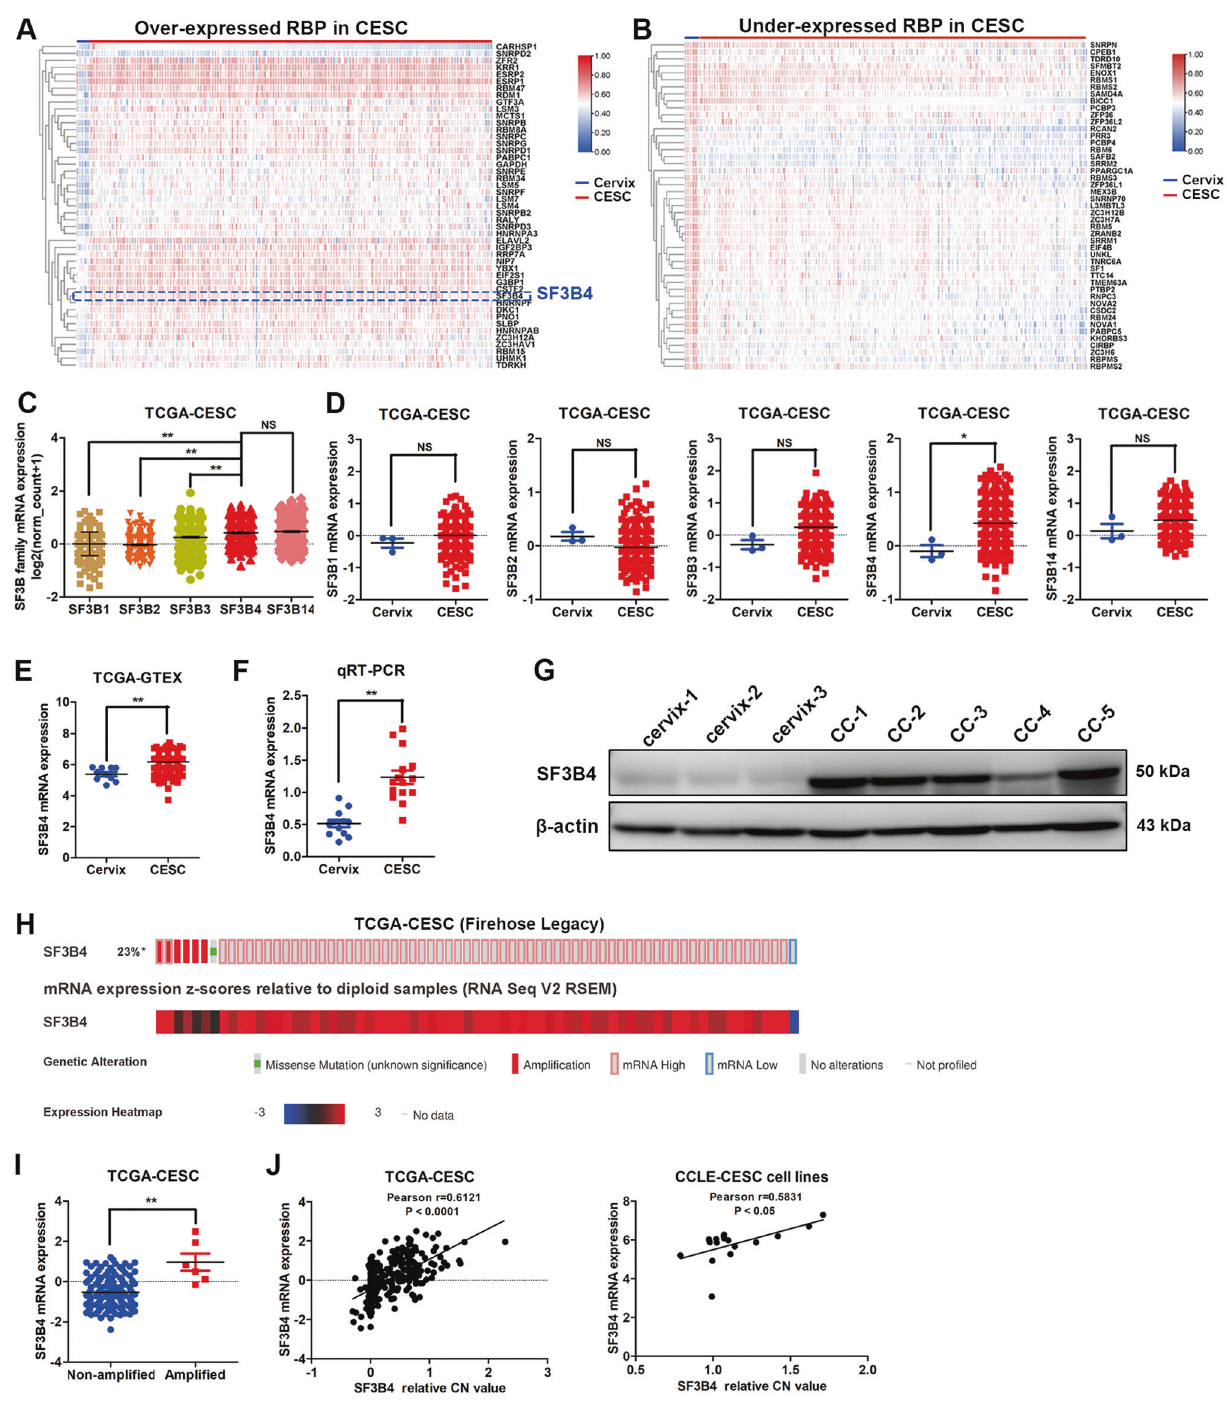
Fig. 1 SF3B4 is overexpressed in cervical cancer. A , B Overlapping analysis of differentially expressed genes from the TCGA-CESC database and classical human RBPs from RBPDB (http://rbpdb.ccbr.utoronto.ca/). Representative overexpressed and downregulated RBPs are presented based on a heatmap. C , D Differential mRNA expression analysis of SF3B family members between cervical cancer ( n = 305) and normal cervical tissues ( n = 3) from TCGA-CESC database. E The differential mRNA expression of SF3B4 between cervical cancer ( n = 306) and normal cervical ( n = 10) tissues from the TCGA and GTEx databases. F qRT-PCR analysis of SF3B4 mRNA expression between normal cervix ( n = 12) and cervical cancer fresh-frozen tissues ( n = 15). G Western blot analysis of SF3B4 protein expression between normal cervix ( n = 3) and cervical cancer ( n = 5) fresh-frozen tissues. H The genomic and mRNA expression alteration of SF3B4 in TCGA-CESC ( n = 310) from cBioPortal for Cancer Genomics (http://www.cbioportal.org/). I Differential mRNA expression analysis of SF3B4 in ampli fi ed samples ( n = 136) compared with nonampli fi ed samples ( n = 6) in TCGA-CESC from cBioPortal for Cancer Genomics. J Correlation analysis between SF3B4 mRNA expression and relative copy number variation in TCGA-CESC ( n = 292) and CCLE-CESC cell lines ( n = 17). P value was obtained by Unpaired t-test. * P < 0.05, ** P <